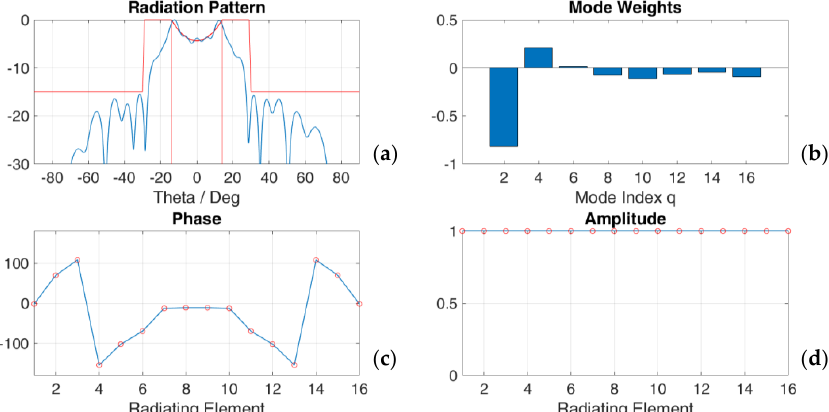
Figure 8. Phase-only synthesis with 16 radiating elements and 8 even Chebyshev basis functions. Element spacing is 0.65 λ 0 . ( a ) Radiation pattern; ( b ) Basis function weights; ( c ) Excitation phase; ( d ) Excitation amplitude.